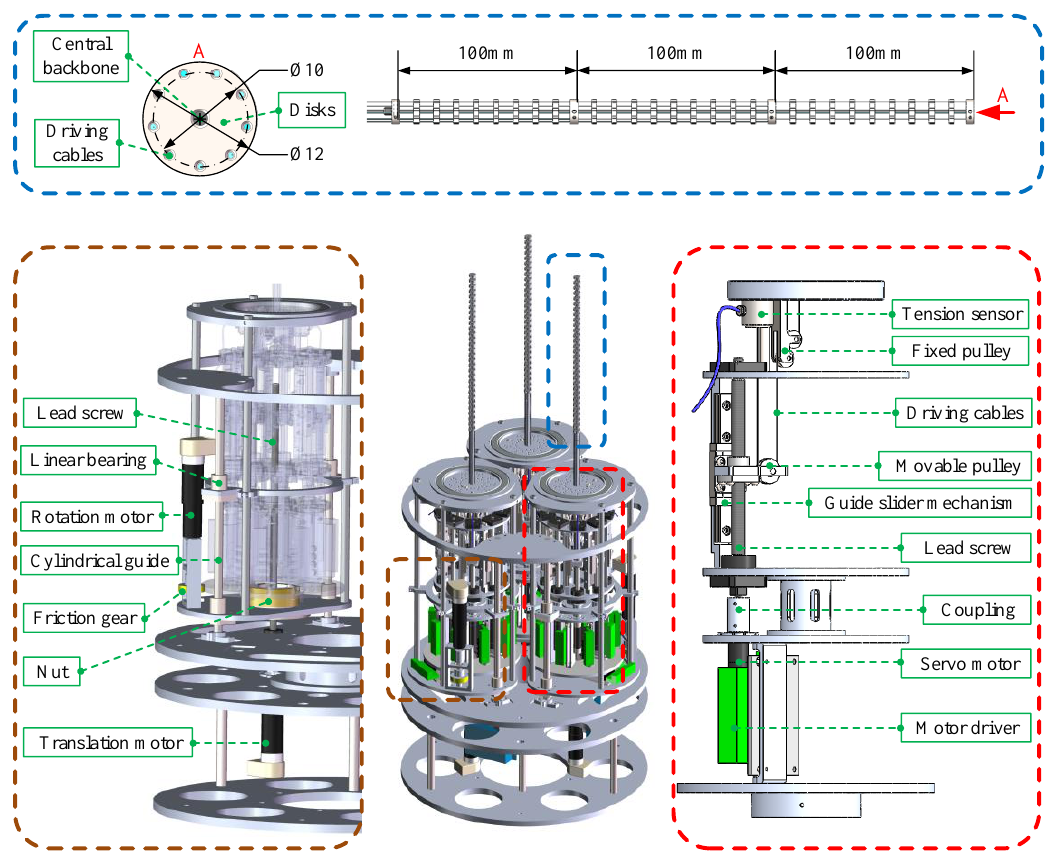
Figure 2. The schematic of the overall structure of the proposed multi-arm space robot. The central backbone of the arm is made of super-elastic nickel–titanium alloy material. Most support disks are manufactured using 3D printing and glued to the central backbone. The disks at the end of each section are made of steel and fixed by tightening screws for it needs to bear a large tensile force during bending. The above design not only ensures the structural strength of the arm but also reduces its mass, which is about 30 g.